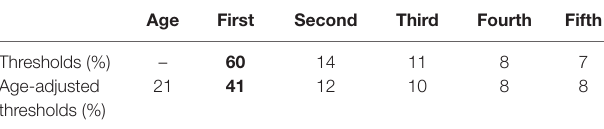
TaBle 5 | Variance explained by each principal component after considering the variance explained by age adjustment.